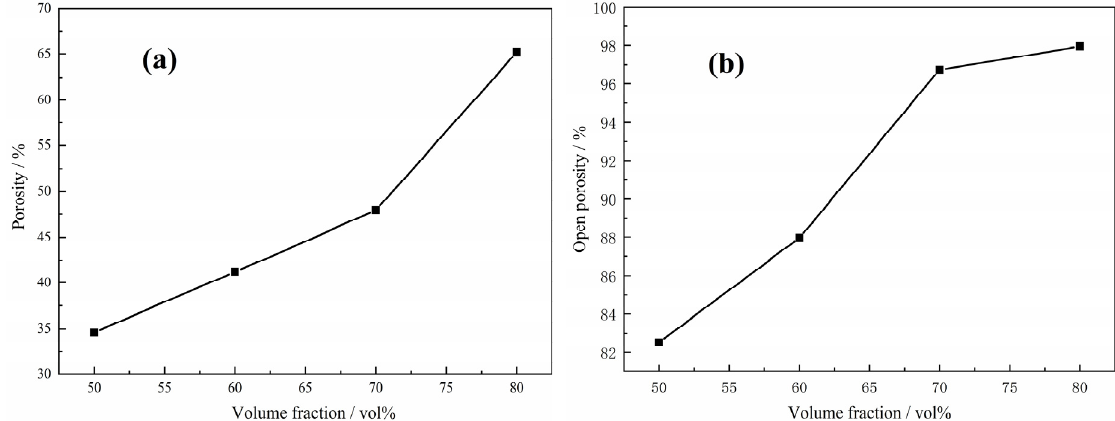
Figure 12. Relationship between porosity ( a ), open porosity ( b ) and volume fraction of magnesium powders in the green compacts by Mg powders and Ti powders.